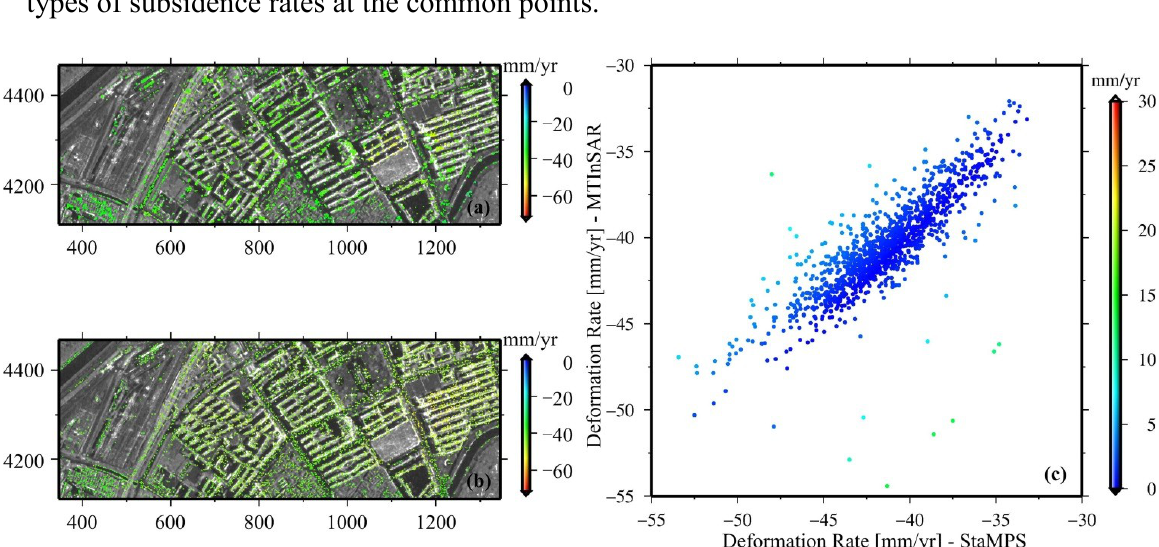
Figure 8. A comparison of the subsidence rates in the rectangle area marked in Figure 7a ( a ) for subsidence rates by our MTInSAR method; ( b ) for subsidence rates by the Stanford Method for persistent scatterer (StaMPS); and ( c ) for the comparison between the two types of subsidence rates at the common points.